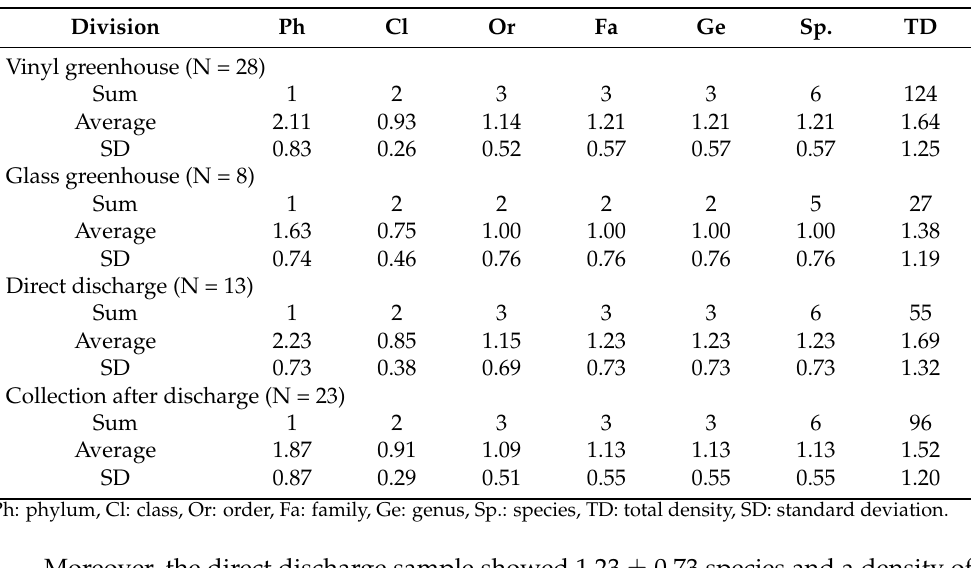
Table 5. Bacteria detected according to the type of greenhouse and drainage.